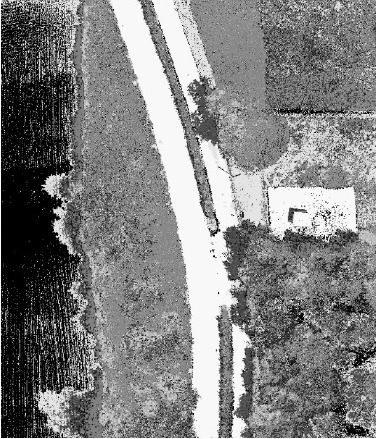
Figure 13. The classified area (10